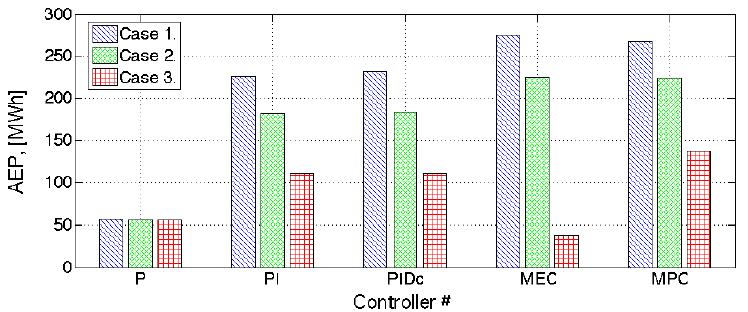
Figure 4. AEP of the WEC as a function of the applied controller for each simulated case. Control type proportional (P) controller, proportional-integral (PI) controller, proportional- integral-derivative with memory compensation (PID) controller, maximum energy controller (MEC) and model predictive control